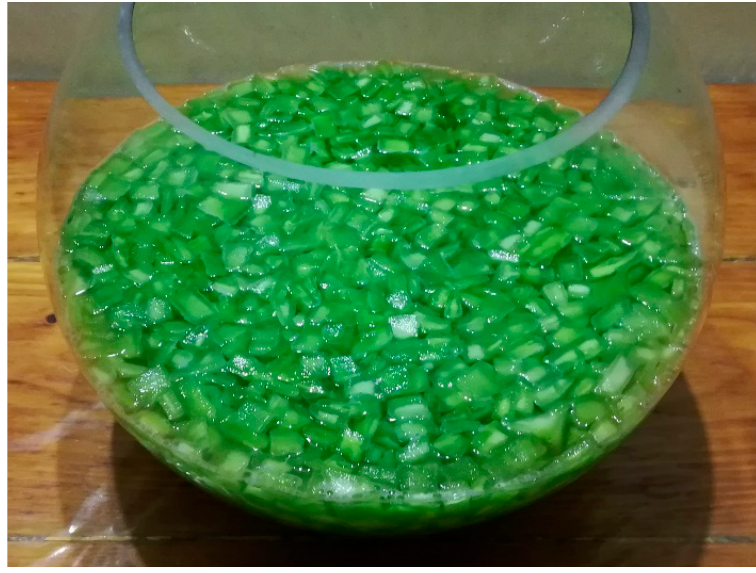
Figure 2. Pieces of isolated parenchyma in a distilled water solution for maceration.